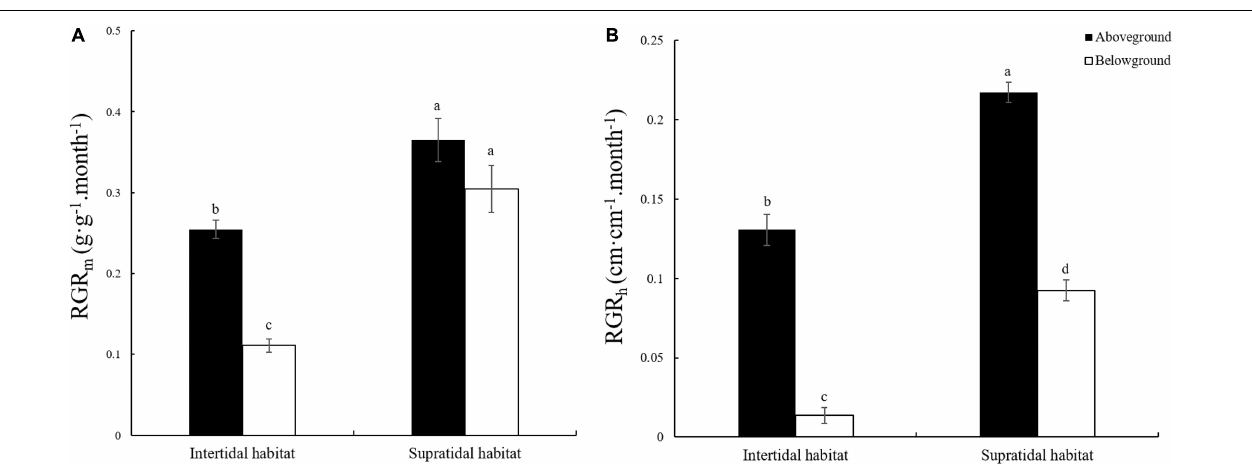
FIGURE 2 | Relative growth rate (RGR) of the aboveground and belowground parts of S. salsa in the intertidal and the supratidal habitats. (A) RGR based on biomass (RGR m ); (B) RGR based on height (RGR h ). Different lower-case letters indicate significant differences ( p <